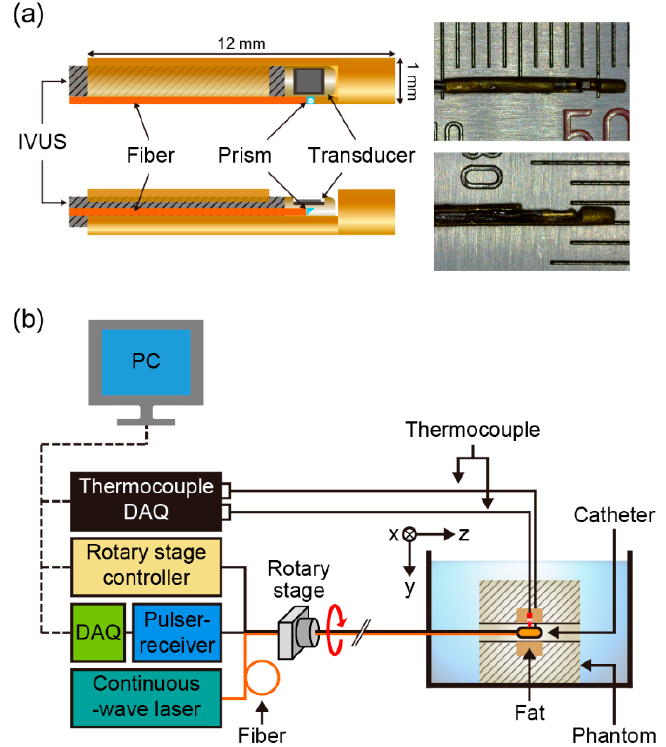
Figure 1. ( a ) Schematics and photographs of an intravascular photothermal imaging (pTSI) catheter. ( b ) A schematic of the intravascular pTSI experimental setup. DAQ: data acquisition system.